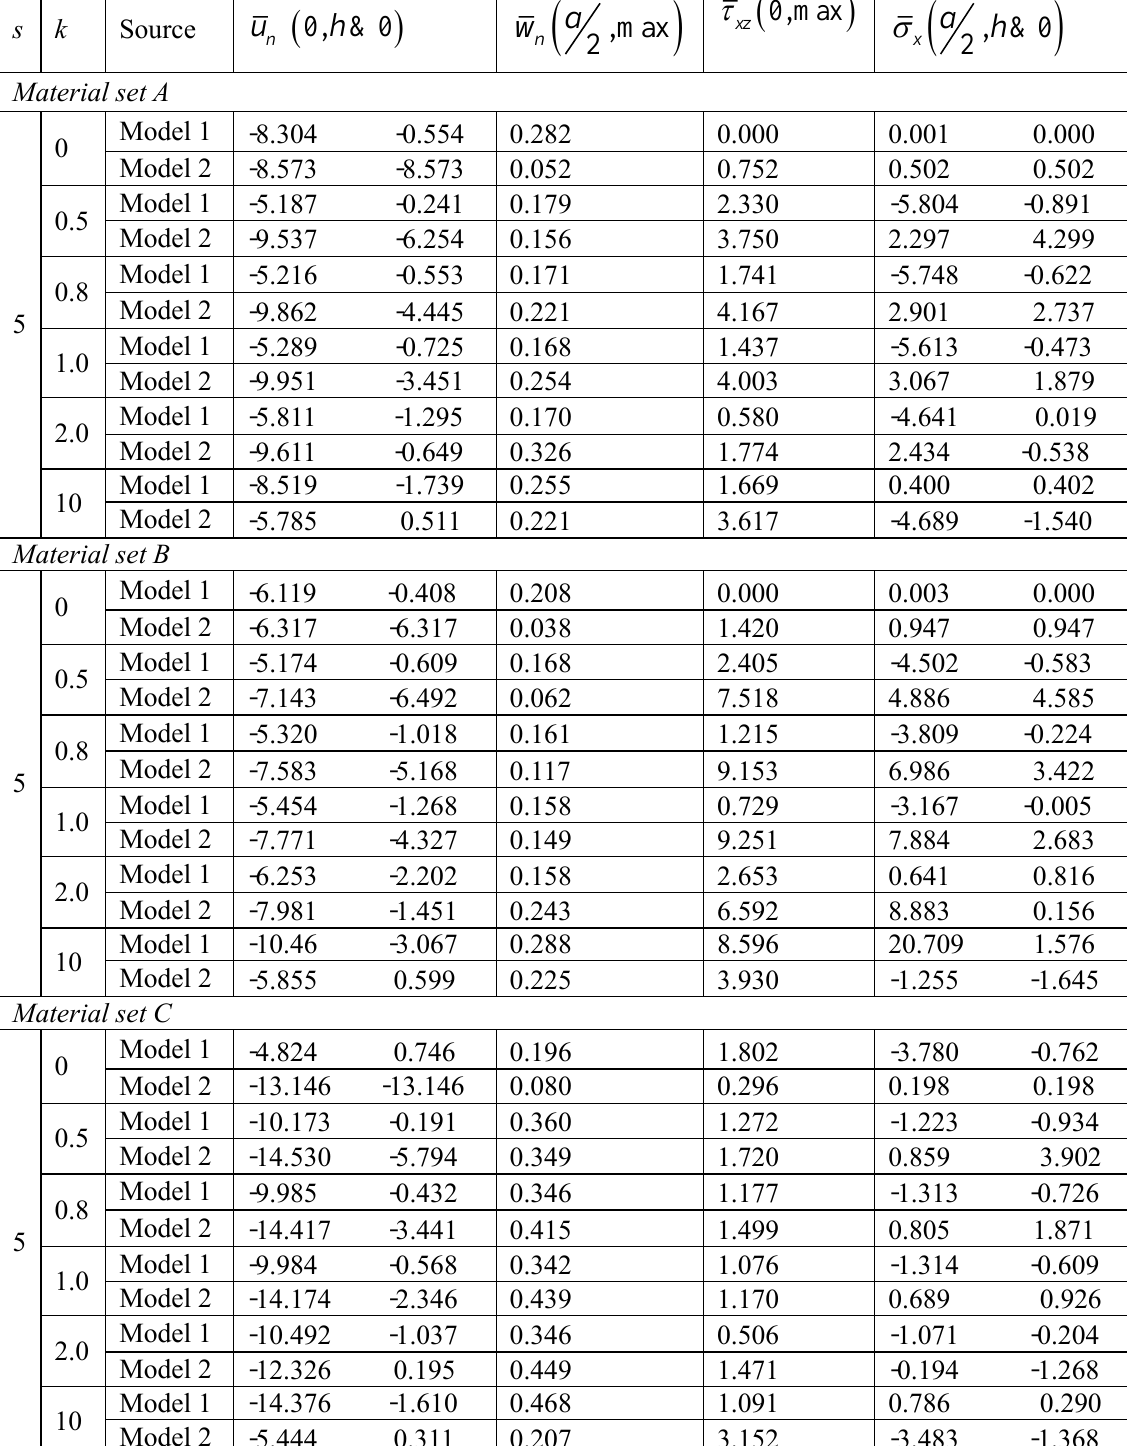
Table 4. Normalized in-plane and transverse displacements thermal loading for material set A, B, and